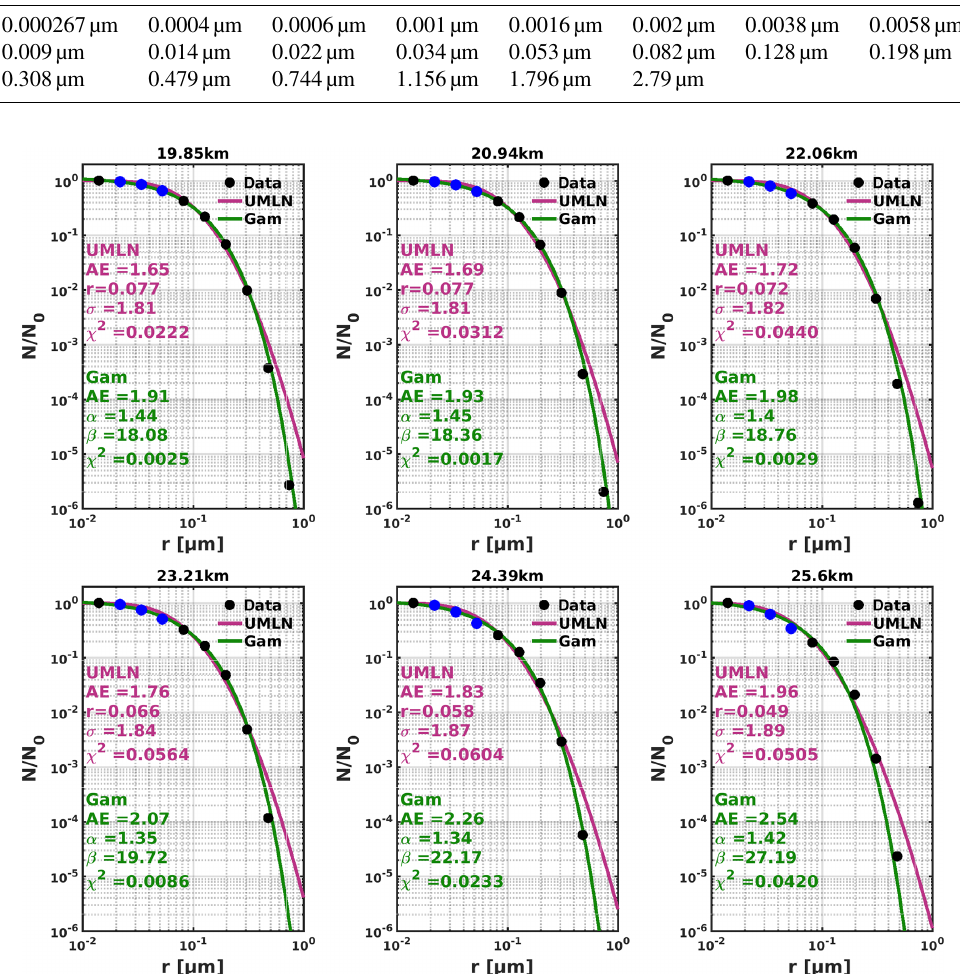
Figure 7. Unimodal lognormal and gamma distribution fits to the normalized CARMA model data. The blue data points are excluded during the fitting procedure but are included during the validation of the fits. The green lines are the gamma distribution fits and the purple lines are the UMLN distribution